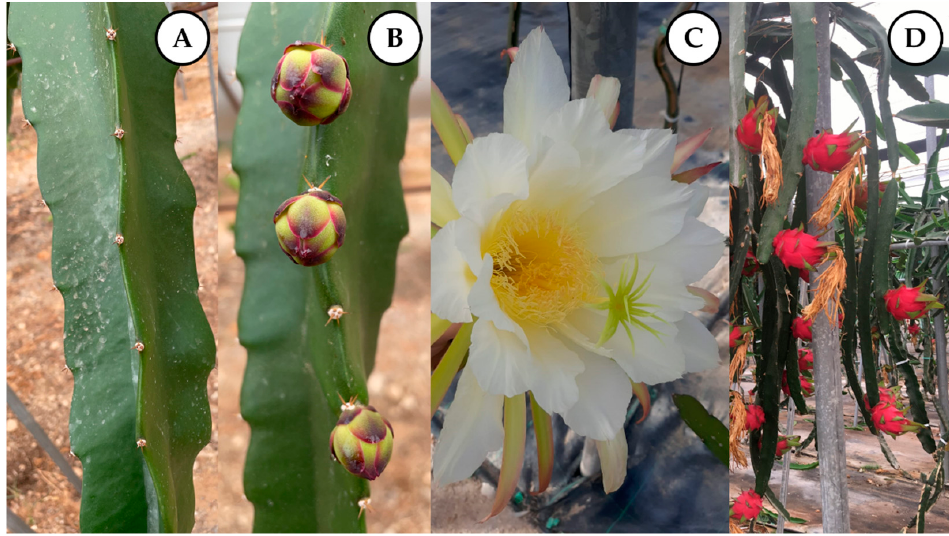
Figure 1. Morphological details of pitaya: triangular cladodes ( A ), areoles and floral buds ( B ), flower ( C ), and fruits ( D ).